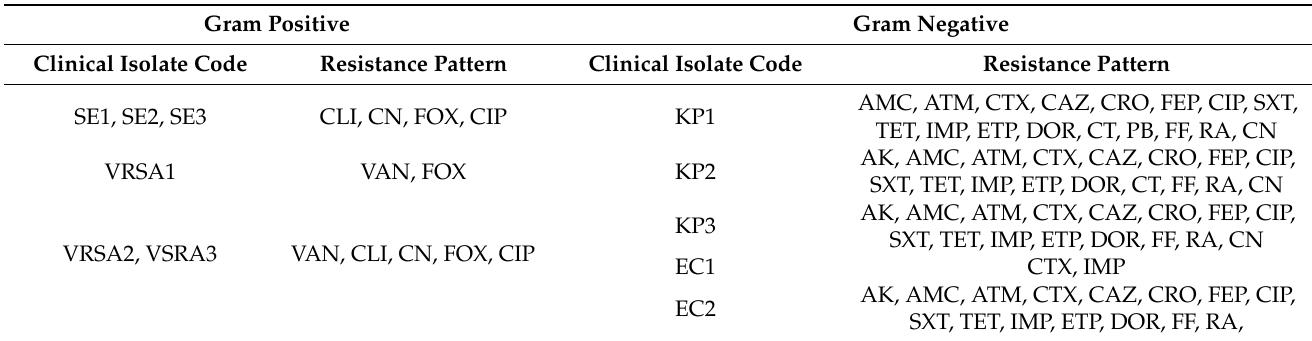
Table 4. Antimicrobial resistance profile of the bacterial clinical isolates.